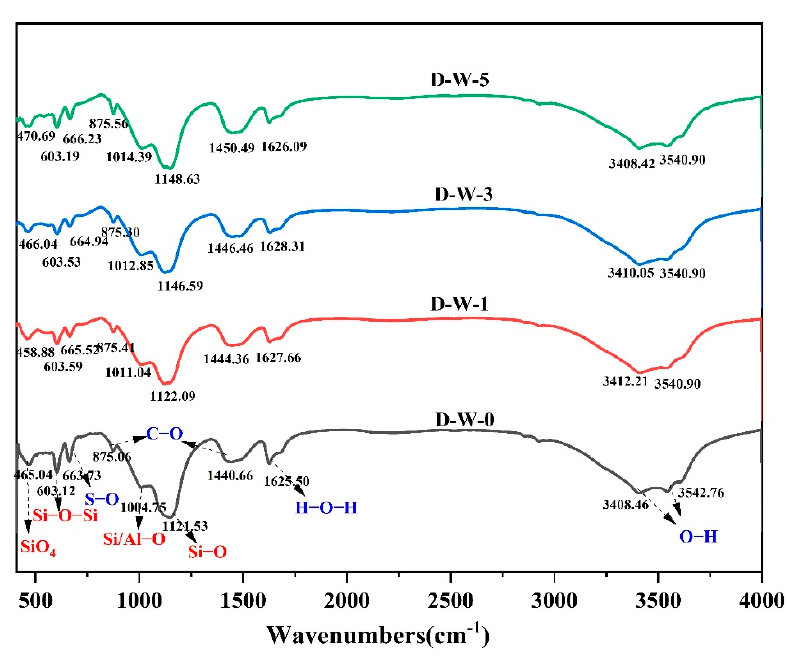
Figure 8. X ‐ ray diffraction of MS16 sample. Figure 8. X-ray diffraction of MS16 sample.